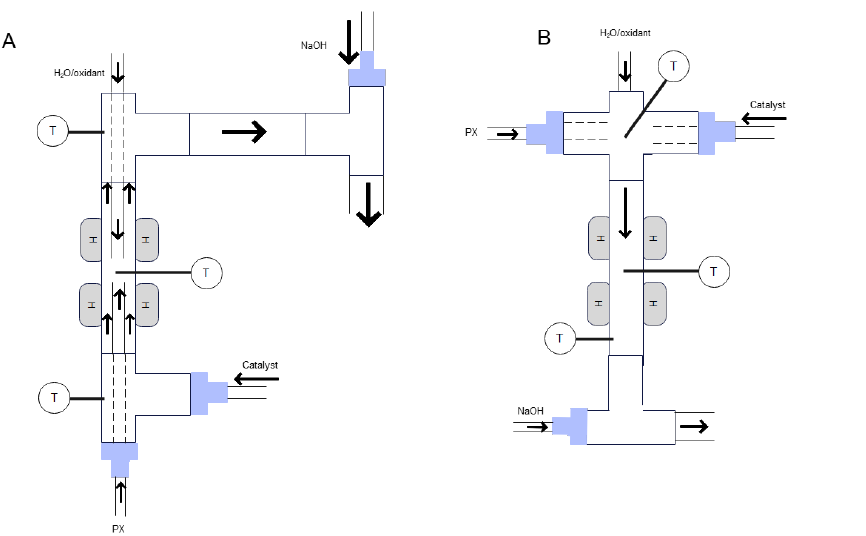
Figure 12. Representation of the ( A ) opposed-flow reactor and ( B ) tubular reactor, where elements labeled H are heating blocks. Adapted from